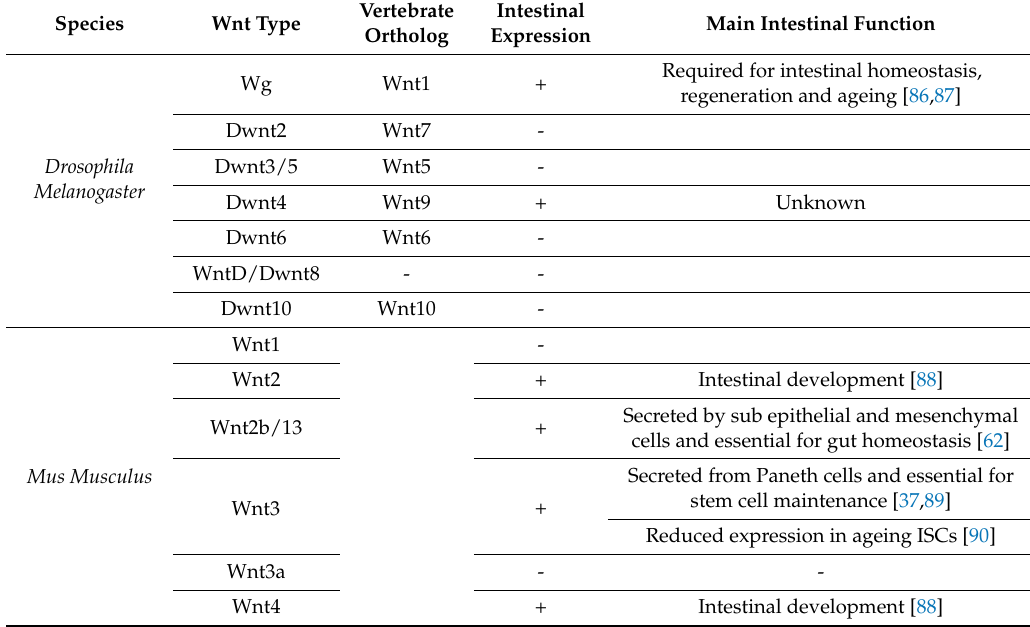
Table 1. List of fly and mammalian Wnts and their expression and function within the intestine. Known fly and mammalian Wnt ligand genes and their expression status in the intestine as determined by FlyGut-seq and NCBI, respectively. Reported intestinal function of Wnts is